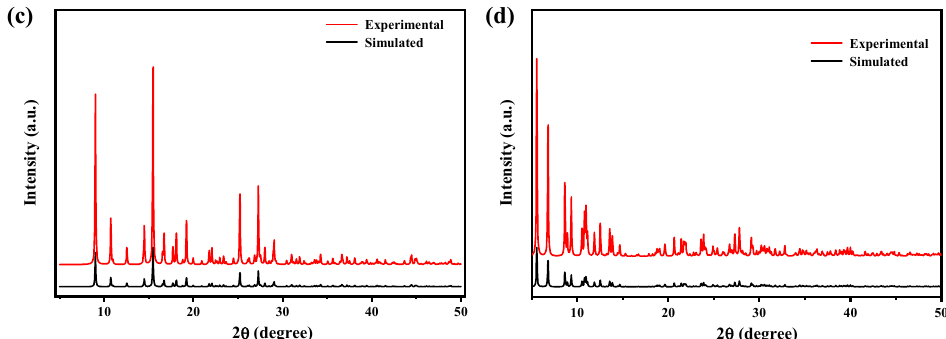
Figure 3. ( a ) PXRD pattern of compound 1 , ( b ) PXRD pattern of compound 2 , ( c ) PXRD pattern of compound 3 , ( d ) PXRD pattern of compound 4 .